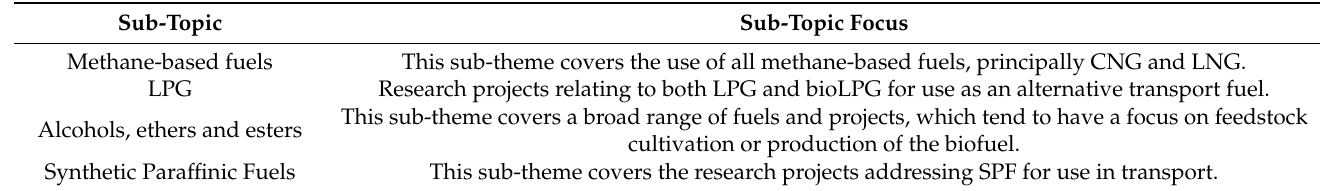
Table 1. Low-emission alternative energy for transport sub-topics.